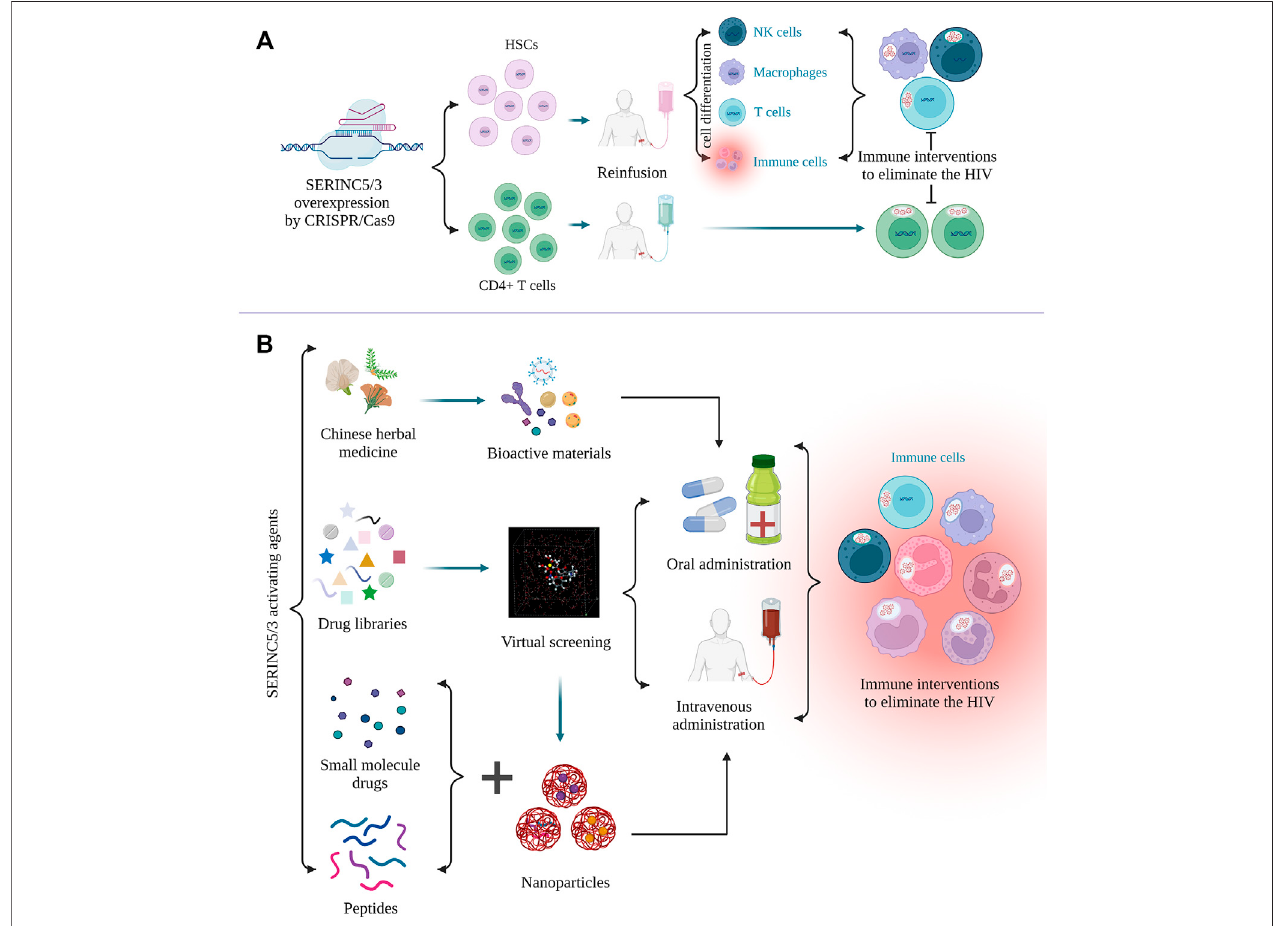
FIGURE 4 | Targeting strategies against HIV by regulating SERINC5/3. (A) , CRISPER/Cas9 gene editing can be used to overexpress SERINC5/3 to increase the differentiation of human-induced pluripotent stem cells (iPSCs) into different immune cells, such as T cells and macrophages. SERINC5/3 was overexpressed in CD4 + T cells, and these immune cells can eliminate HIV loads. (B) , To activate SERINC5/3 modi fi cation activity or increase the protein expression of SERINC5/3 to defend againstHIV, active materials, such as monomers in Chinese herbal medicine, small molecules, and peptides should be selected and their activity con fi rmed. Using thecrystalstructureofvirusbindingtotheSERINCs,additionaldrugsfrommolecularlibrariescanbefoundbyvirtualscreening.Toef fi cientlydelivertheselecteddrugsor peptides, nanoparticles should be considered as a carrier. (Created by Biorender.com).